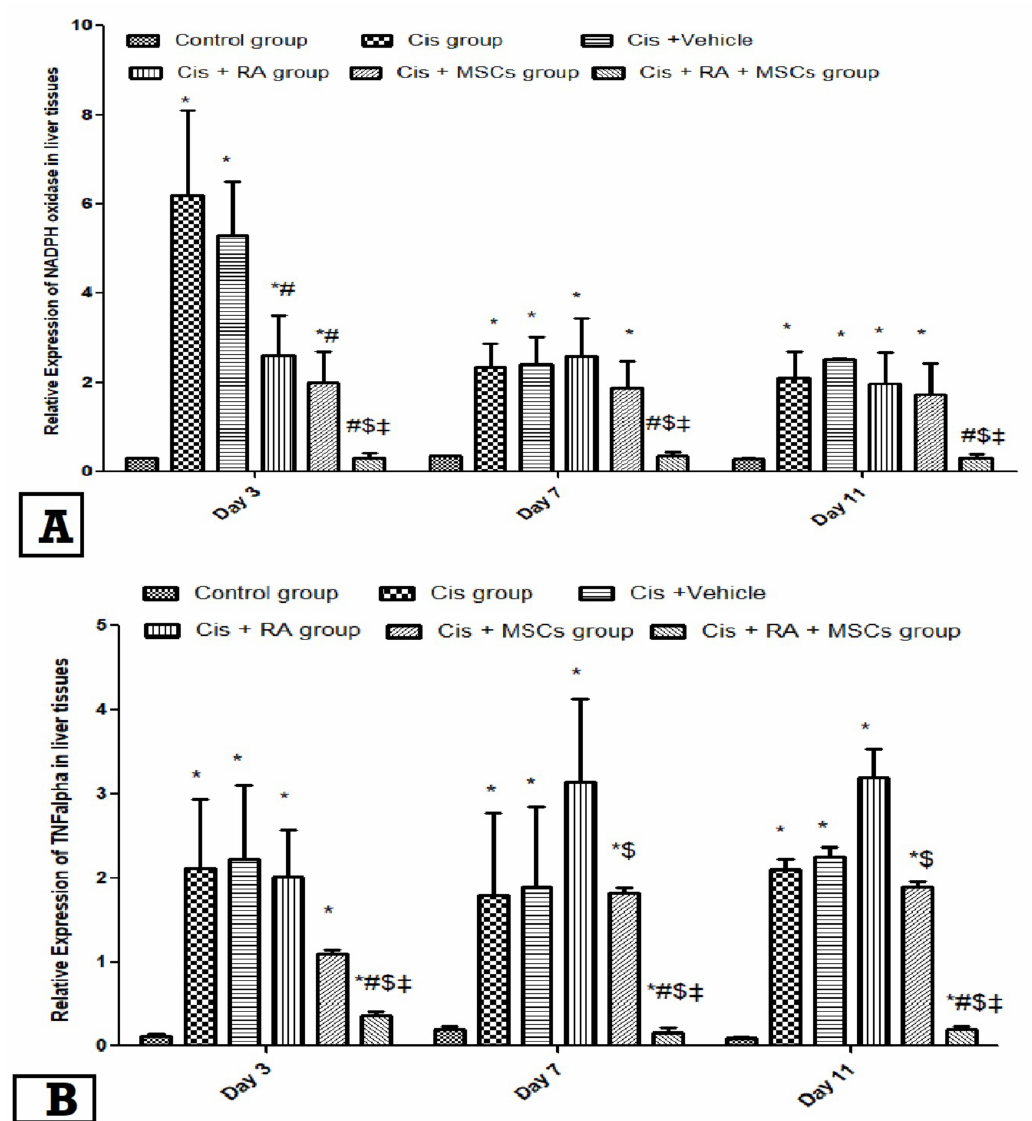
Figure 4. Relative gene expression of ( A ) TNF-alpha and ( B ) NADPH oxidase genes at the level of mRNA. * Significant vs. control group, # significant vs. Cis group, $ significant vs. Cis + MSCs group and ‡ significant vs. RA